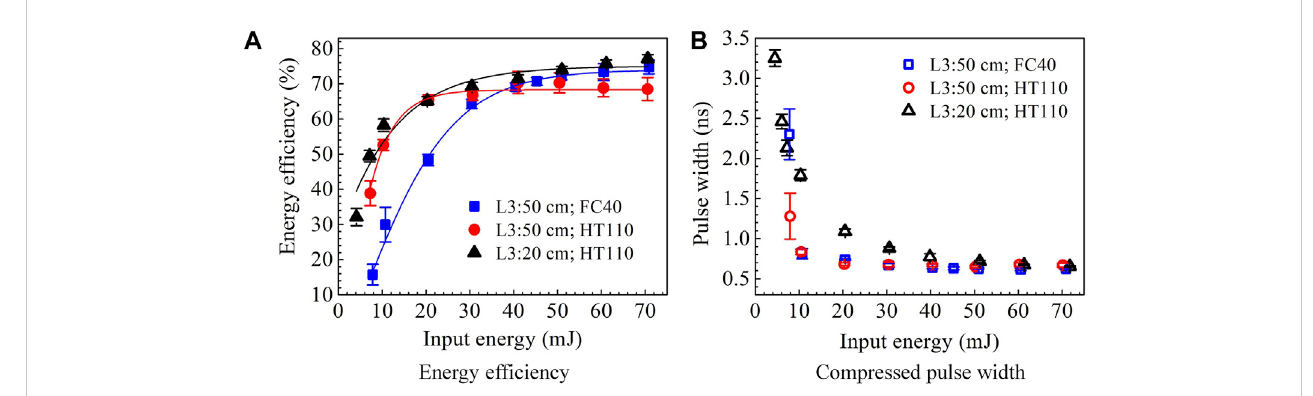
FIGURE 3 Output parameters with different focal lengths of lens L3 and media for setup A.